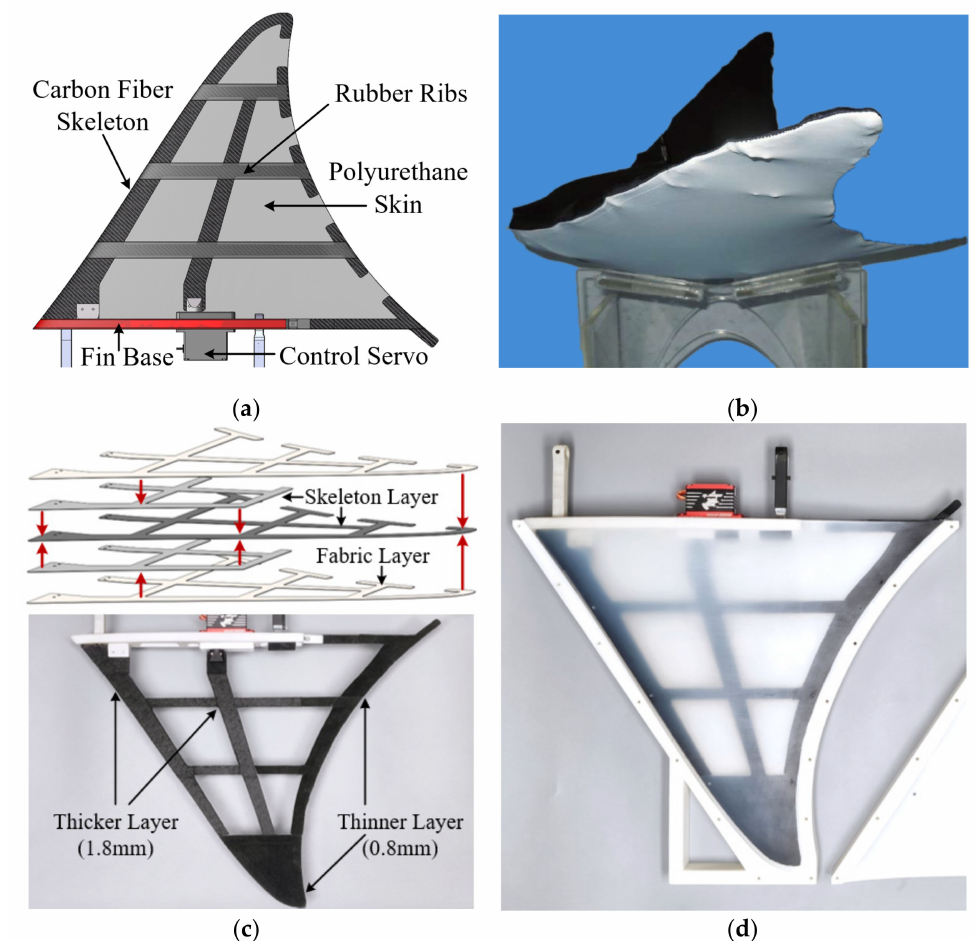
Figure 5. Structure of two different bionic fin types. ( a ) Inner structure of the 3D hollow fin with permeable skin; ( b ) photo of the robot ray covered by the polyurethane skin; ( c ) sandwich structure of the multi-layer bionic fin skeleton; ( d ) photo of the 3D solid fin constructed with soft rubber and its 3D-printed